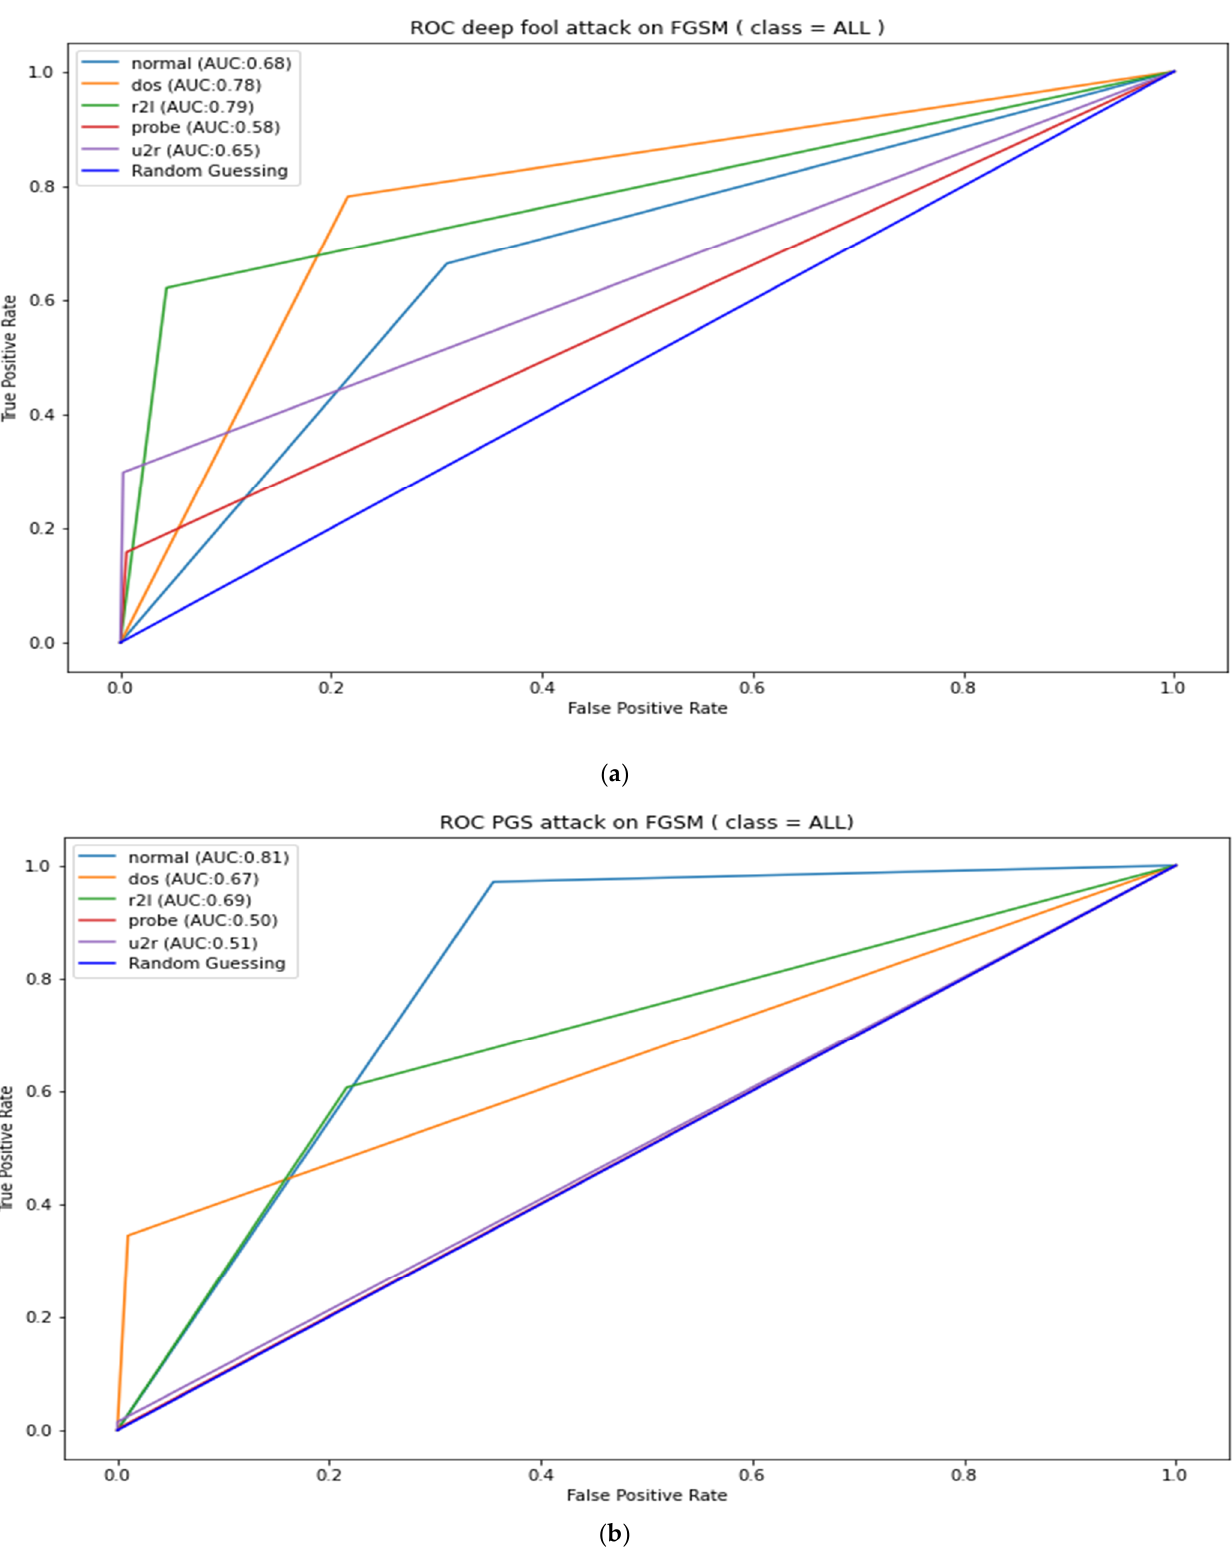
Figure A3. FGSM robustness test against DeepFool ( a ) and PGD attacks ( b ).